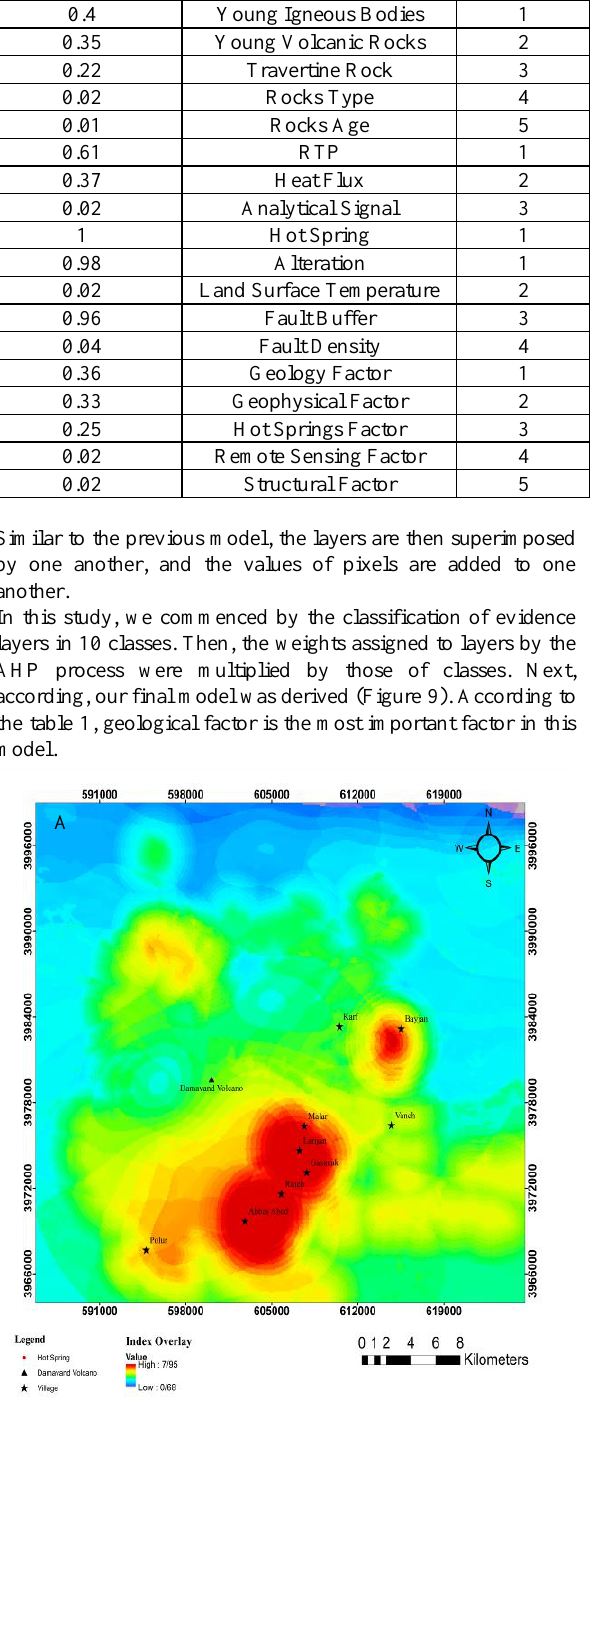
Figure 7. Combination of evidence layers by multi-class cumulative overlay with two input layers